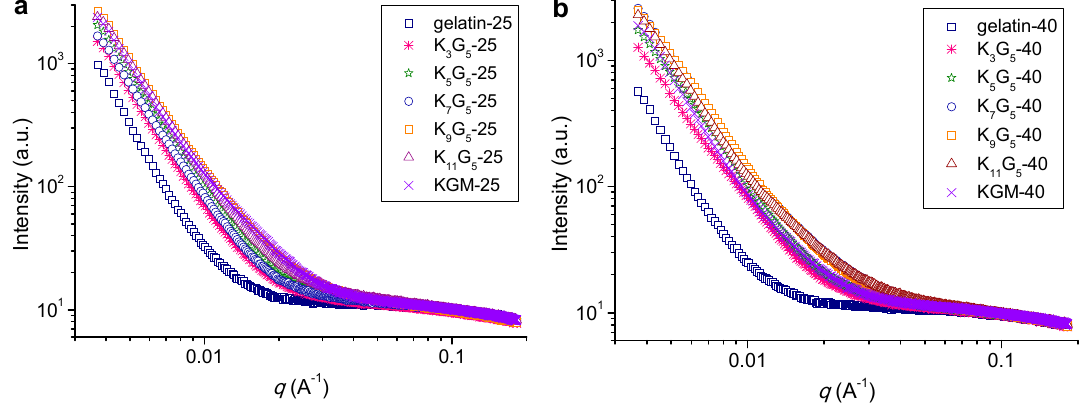
Figure 3. SAXS patterns of KGM, gelatin, and KGM / gelatin films formed at drying temperatures of 25 ( a ) or 40 °C ( b ).